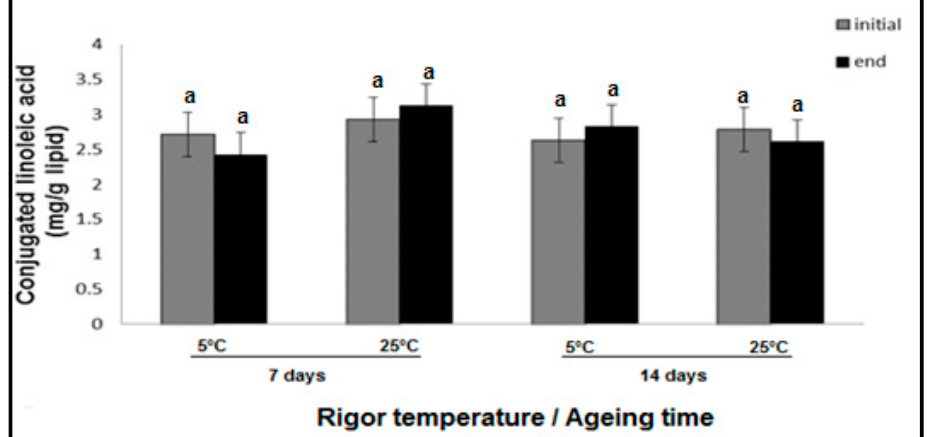
Figure 3. CLA concentrations in hot boned beef SM muscle lipid determined by 1 H NMR. Bars represent Mean ± SEM ( n = 6). Bars with different superscripts are significantly different at ( p > 0.05). Key: “initial” CLA concentrations were obtained at the start of display time. The “end” CLA concentrations were obtained at the completion of 7 days of display time.